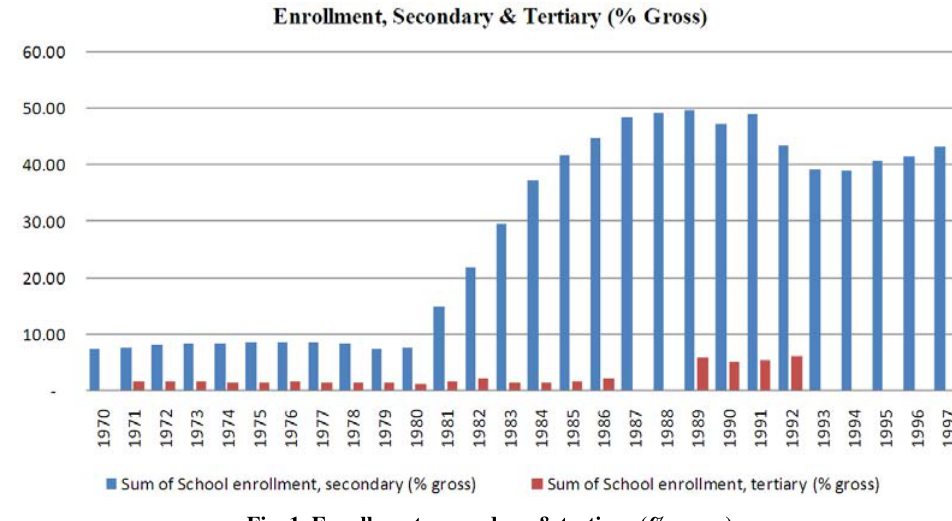
Fig. 1. Enrollment, secondary & tertiary (%